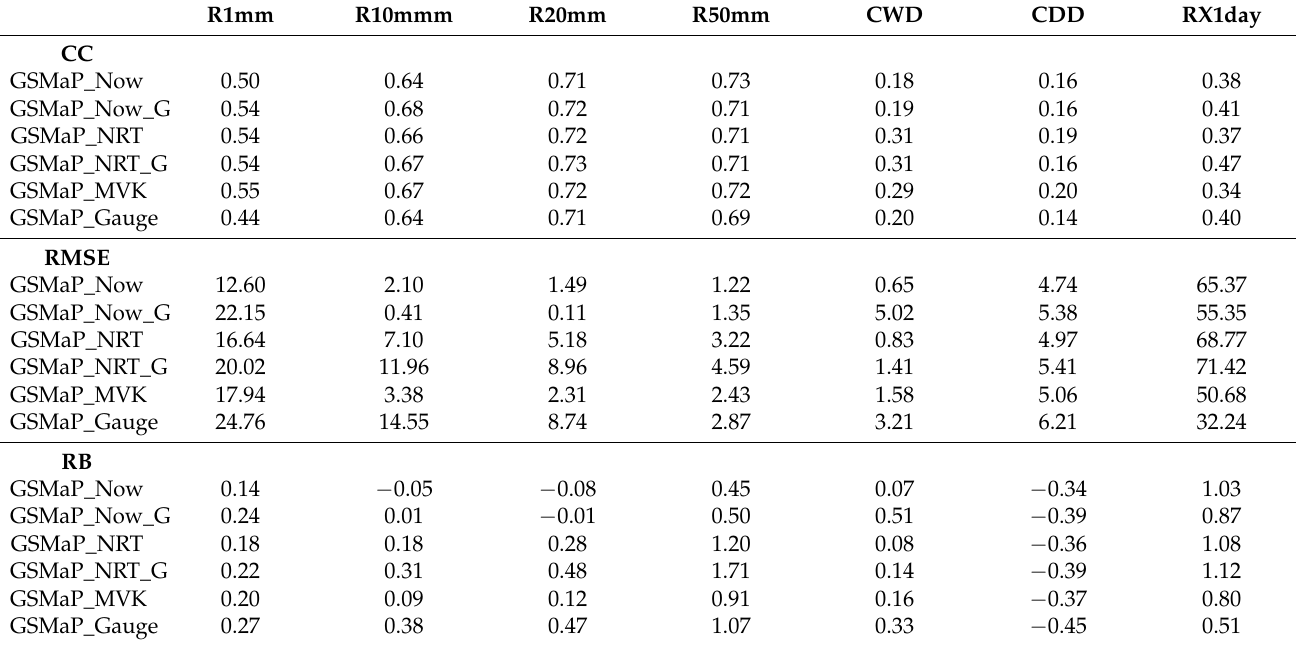
Table 7. The continuous statistical metrics for several extreme indices from GSMaP